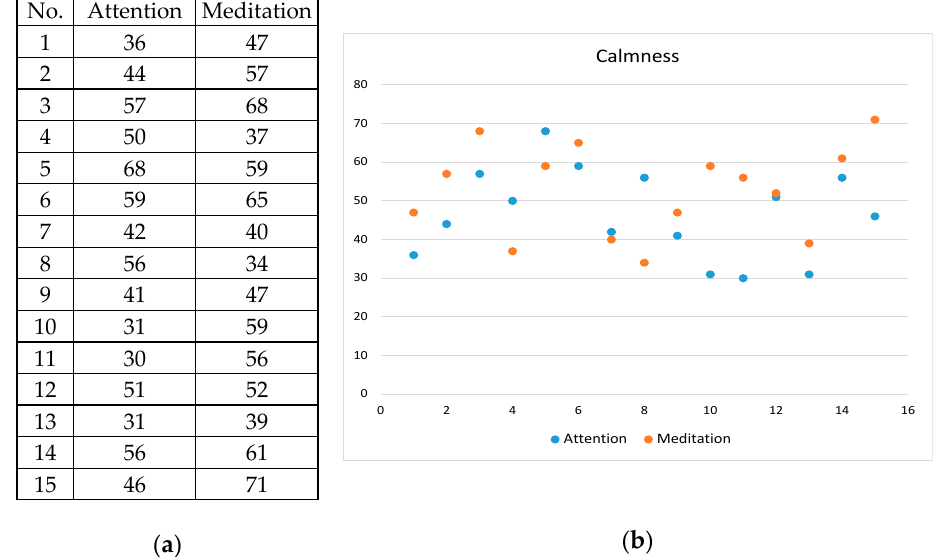
( b ) Figure A4. The data and the distribution graph of the average values of the 15 measured two-feature sample sequences of the emotion type of anxiety, from which the corresponding decision rule a < 30 or m < 30 for emotion classification was inferred, where m and a represent the meditation and attention signals, respectively. ( a ) The average data. ( b ) The distribution graph. Appendix B. Finding the Latent Scales of Questions and Proving the Reliability and Validity of the Questionnaire Data